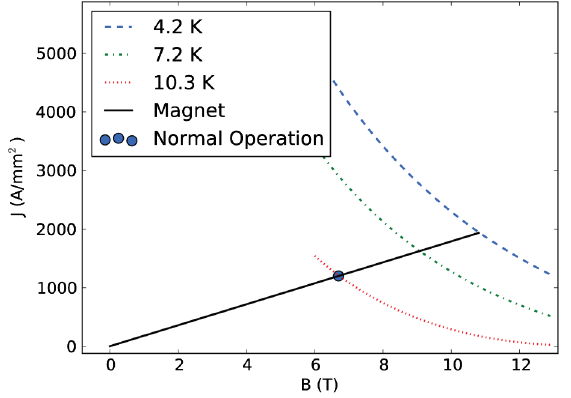
FIG. 46. Load line of the FFAG septum.